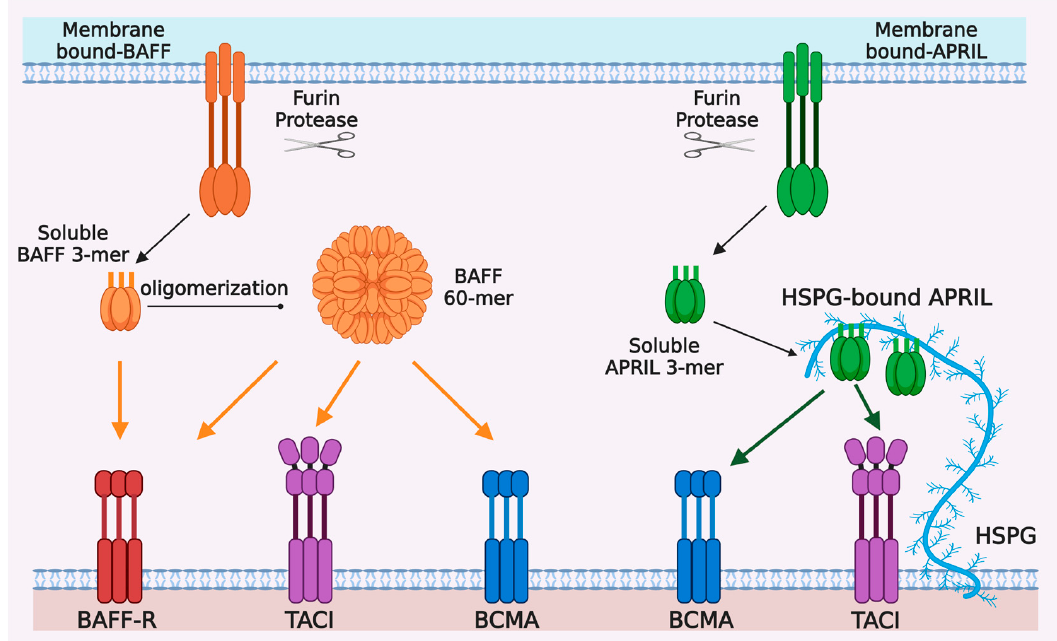
Figure 1. Ligand-receptor interactions in the BAFF / APRIL and BAFF-R / BCMA / TACI system. BAFF and APRIL are first synthetized as type II transmembrane proteins, mainly in myeloid and stromal cells, and processed by furin protease into trimeric soluble cytokines BAFF 3-mer and APRIL 3-mer. Twenty soluble BAFF 3-mers can be further oligomerized into a virus-like particle, called BAFF 60-mer. BAFF-R, BCMA, and TACI are type I transmembrane proteins belonging to tumor necrosis factor receptor (TNFR) superfamily and mainly expressed by B cells at di ff erent stages of di ff erentiation. BAFF-R and BCMA have only one cysteine-rich domains (CRD) extracellularly, whereas TACI has two CRDs for ligand-binding. BAFF-R only binds BAFF, which can be BAFF 3-mer, BAFF 60-mer or membrane-bound BAFF. BCMA can bind both BAFF and APRIL and has higher binding a ffi nity with APRIL than that with BAFF. TACI also binds to BAFF and APRIL, but it seems to respond better to oligomeric ligands, i.e., BAFF 60-mer or HSPG-bound APRIL, than trimeric soluble